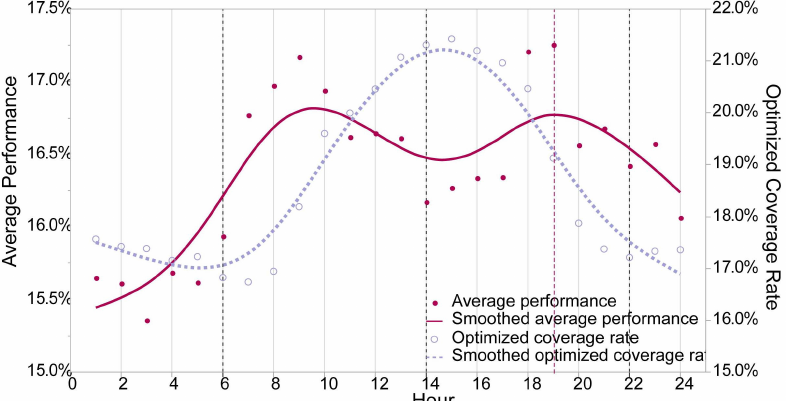
Figure 6. Comparison between the Average Performance of Optimized AEDs and the Optimized AED Coverage Rate across 24 h (k = 100). The average performance of each set of optimized AEDs ( N J (cid:48) ) refers to the average performance applying each set of optimized AEDs to 24 sets of visitor h (cid:48) distributions. The smoothed line is calculated based on a cubic spline with a lambda of